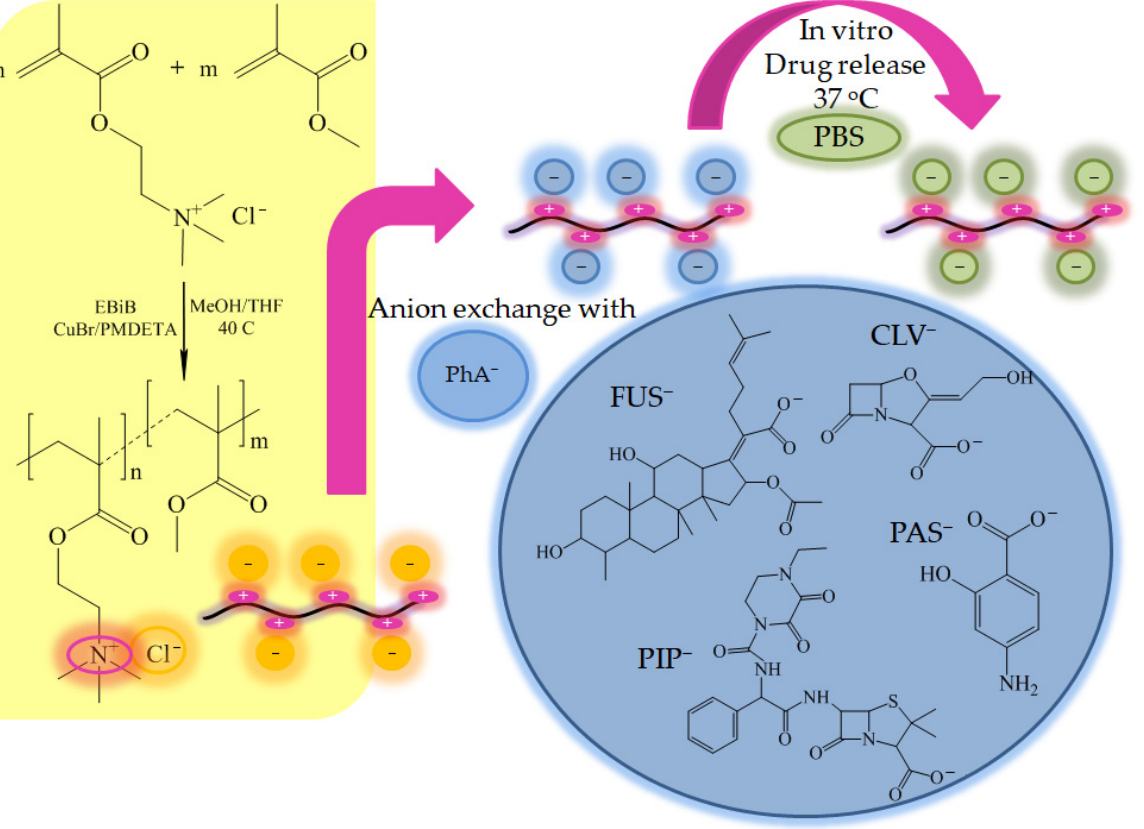
Figure 1. Schematic anion exchange pathway for obtaining linear TMAMA-based copolymers. The copolymer structure was confirmed by proton nuclear magnetic resonance ( 1 H NMR) spectroscopy, which revealed proton signals from methyl groups at 1.4–0.6 ppm and methylene groups at 2.0–1.6 ppm in the main chain (Figure 2). Additionally, signals from methoxy protons at 3.7–3.5 ppm in MMA units, and from oxyethylene and methyl groups in the ammonium cation of TMAMA/Cl units (4H at 4.6–4.1 ppm and 9H groups at 3.4 and 3.3 ppm, respectively) confirmed the incorporation of both monomers into the polymer chain. The 1 H NMR analysis of the reaction mixture allowed for the determina- tion of monomer conversions (Table 1) using the integration of vinyl proton signals as- signed to unreacted TMAMA and MMA (6.2–6.1 ppm and 6.1–6.0 ppm, respectively) rel- ative to signals corresponding to the protons in substituents (both reacted and unreacted monomers), i.e., 9H in -(CH 3 ) 3 N + and 3H in -OCH 3 , respectively. The conversion values could then be used to calculate the other parameters, including the polymerization degree, the ionic unit contents, and the polymer molecular weight (Table 1). The compositions of the final copolymers C1, C2, and C3 containing 24%, 49%, and 75% TMAMA units, re- spectively, were guaranteed by properly assumed initial ratio of monomers. The con- trolled polymerization was also verified by the size-exclusion chromatography (SEC) re- sults, supporting low dispersity indices of the polymers with longer chains (Ð < 1.4 at DP n > 450). The exception for C1 suggests that a lower reaction rate in a system containing predominantly MMA promoted the occurrence of side reactions (Table 1).